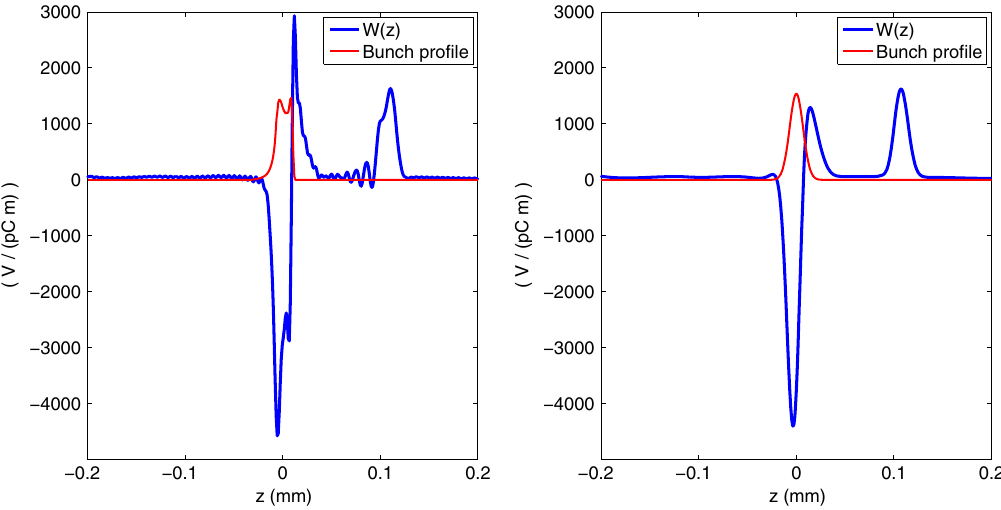
FIG. 19. Wakefield W ð z; s Þ as a function of z ¼ s − β ct at s ¼ 0 . 55 m (end of bend). Graph on left is for the simulated bunch form of Fig. 1, that on right for a Gaussian bunch with the same σ z